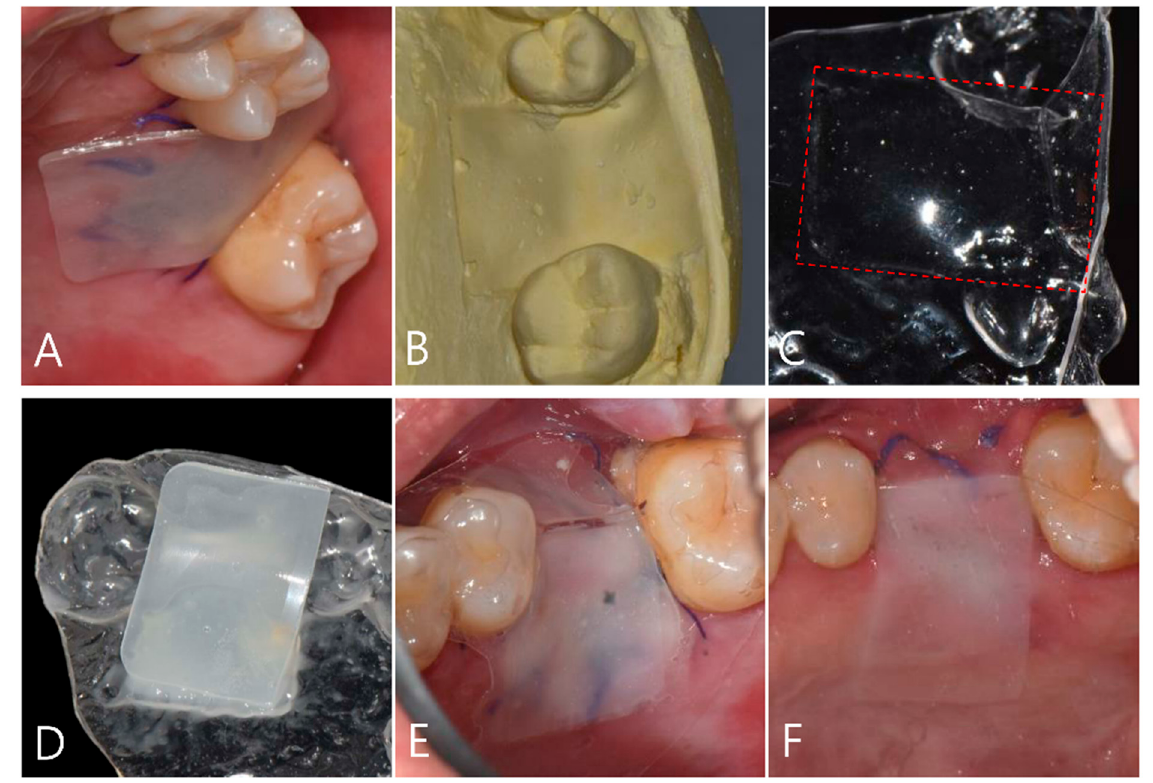
Figure 1. Conservative treatment method for wound dehiscence. ( A , B ). ( A ) cast model was made by covering the band-type dressing material. ( C ) An omnivec splint was fabricated from the impression with the dressing application (red dot squire). ( D , E ) The dressing could be applied accurately with the splint. ( F ) The dressing was well maintained with adhesion to the gingiva after 5–10 min of application.